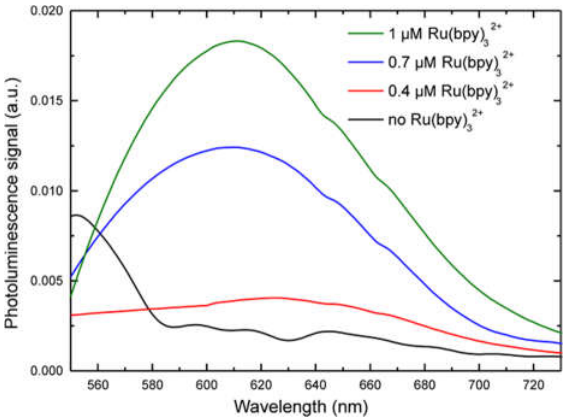
Figure 6. Emission spectra of HDFs controls (black curve) and exposed to 0.4 (red curve), 0.5 (blue curve) and 1 (green curve) μM of Ru(bpy) 32+ for 24 hours. Fluorescence emission was acquired with a 405 nm laser source and revealed a peak at 620–630 nm, specific of fluorophore used, for treated samples while a peak at 550 nm was evidenced for control cells, provided by the intrinsic fluorescence of HDFs.